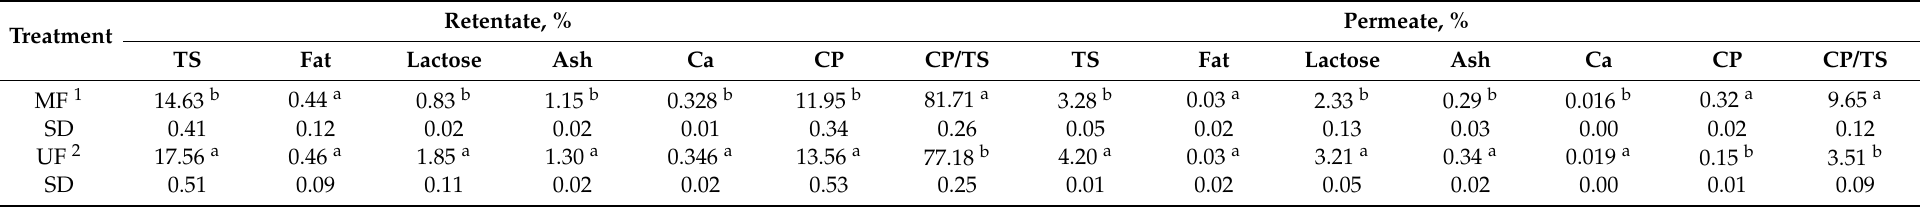
Table 2. Mean ( n = 3) retentate and permeate composition (% by weight) produced during microfiltration and ultrafiltration of skim milk using polymeric spiral-wound membranes. Treatment